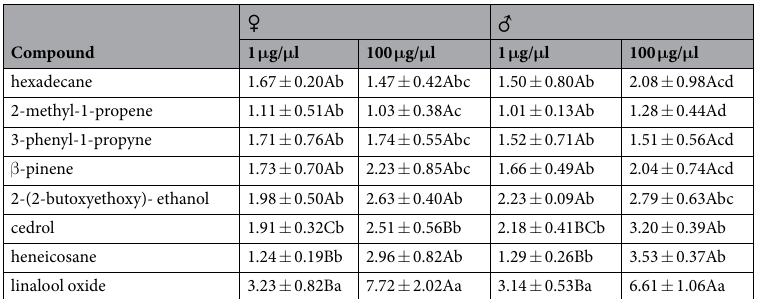
Table 2. Electroantennogram (EAG) responses (Mean ± SD) of Cethosia cyane cyane to a range of doses of eight compounds. Capital letters beside the data show the results of crosswise comparisons, and small letters show the results of lengthwise comparisons; the same letter indicates no significant difference ( P > 0.05), and different letters indicate significant differences ( P <